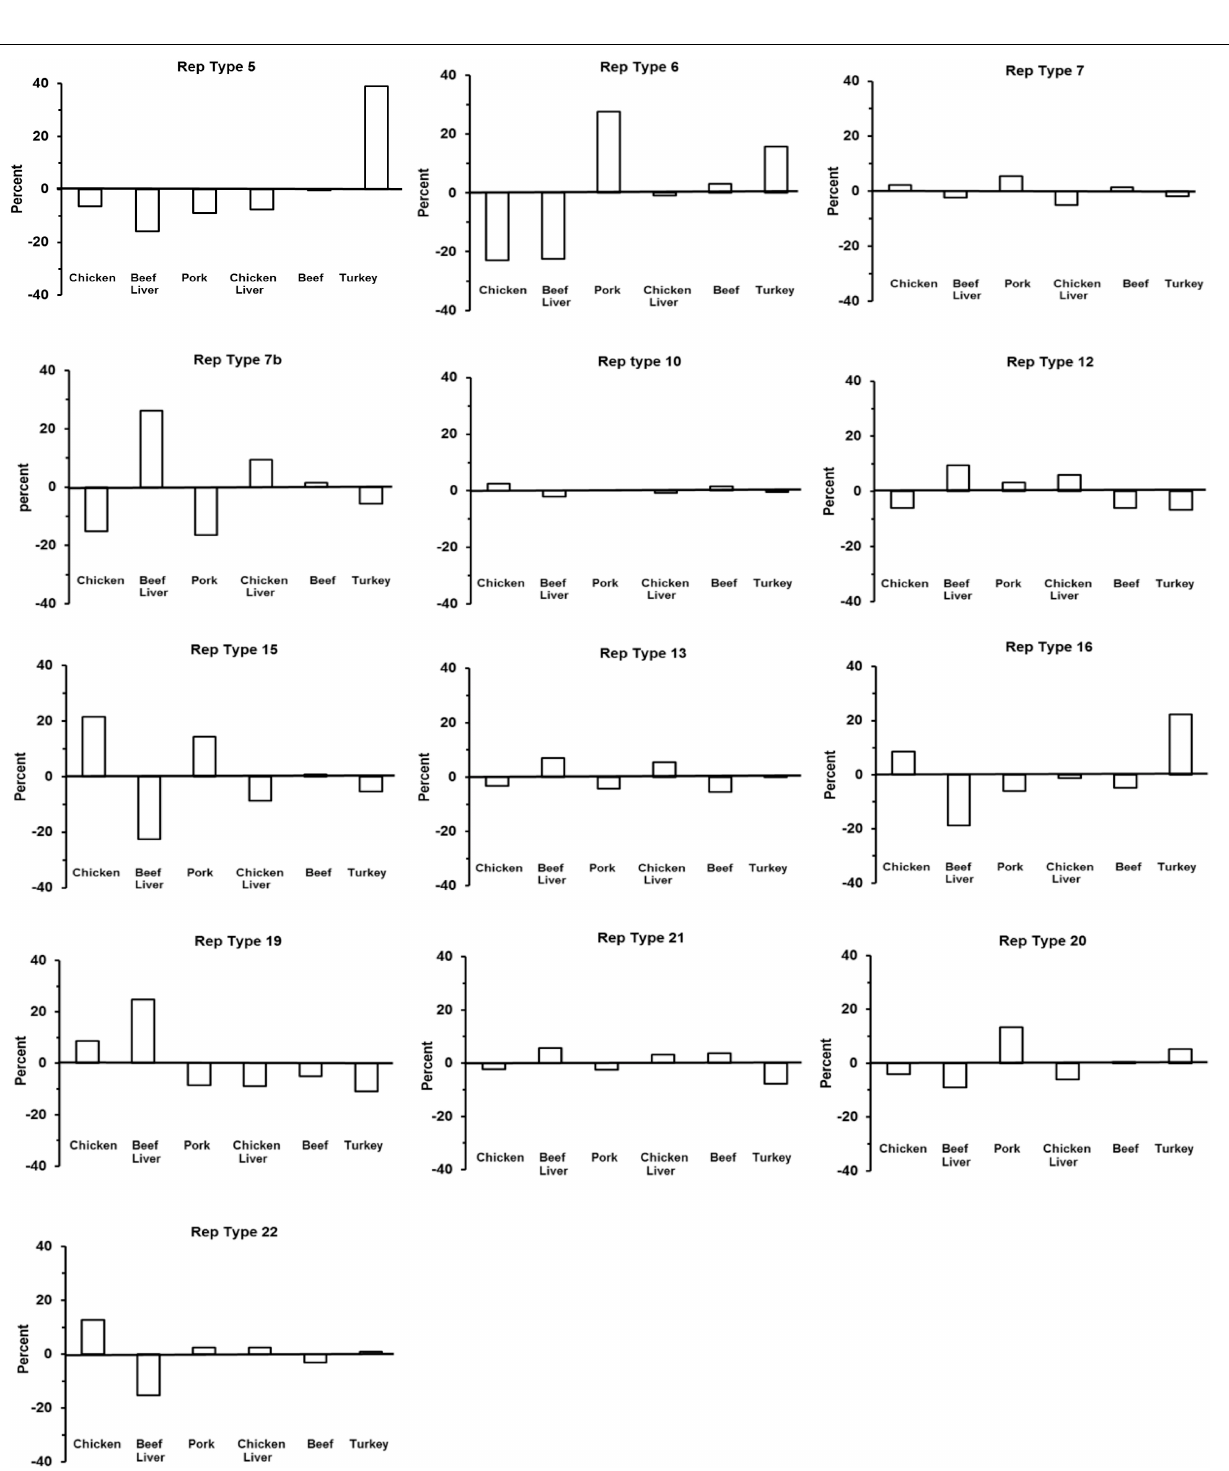
genes, lukS-lukF , were found exclusively in S. aureus isolates containing rep 7 , rep 10 , rep 13 , rep 15 − 16 , rep 19 , and rep 21 − 22 . It is important to note that while these PVL and lukS-lukF genes